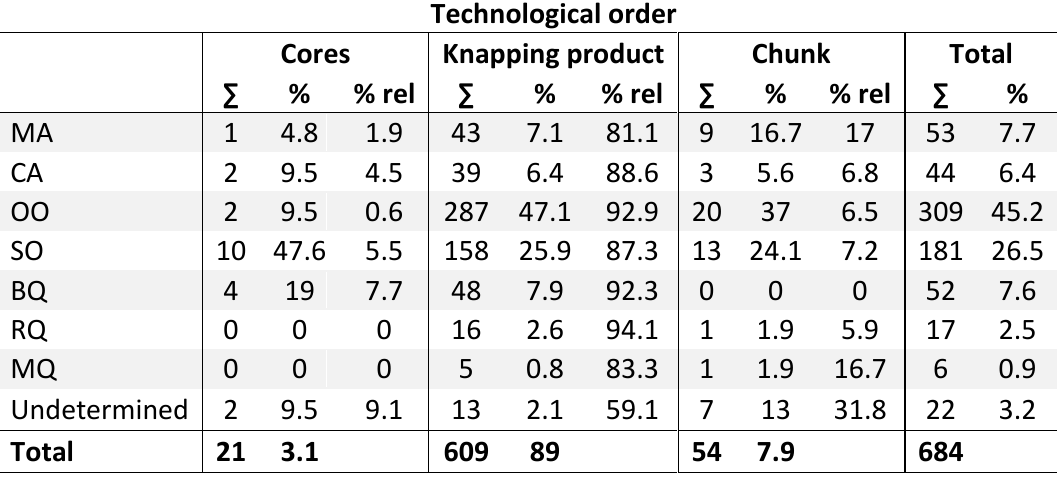
Table 4. Main technological category distribution of each raw material. The % columns are the percentage of each raw material in relation to each technological category, while % rel. is the percentage of each technological category in relation to each